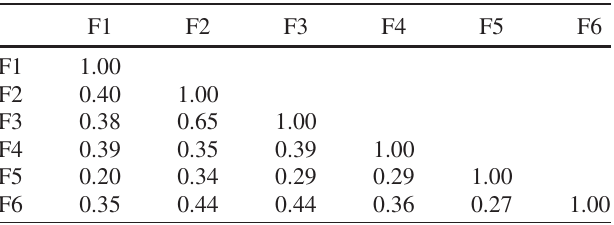
TABLE V. The correlations between each of the factors for the CSEM after an oblimin rotation. Since the matrix is symmetric only the lower left corner is displayed.